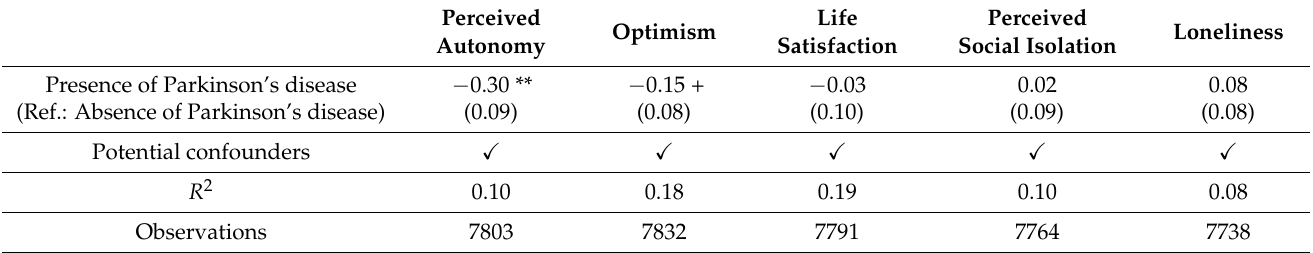
Table 2. Determinants of psychosocial factors. Results of multiple linear